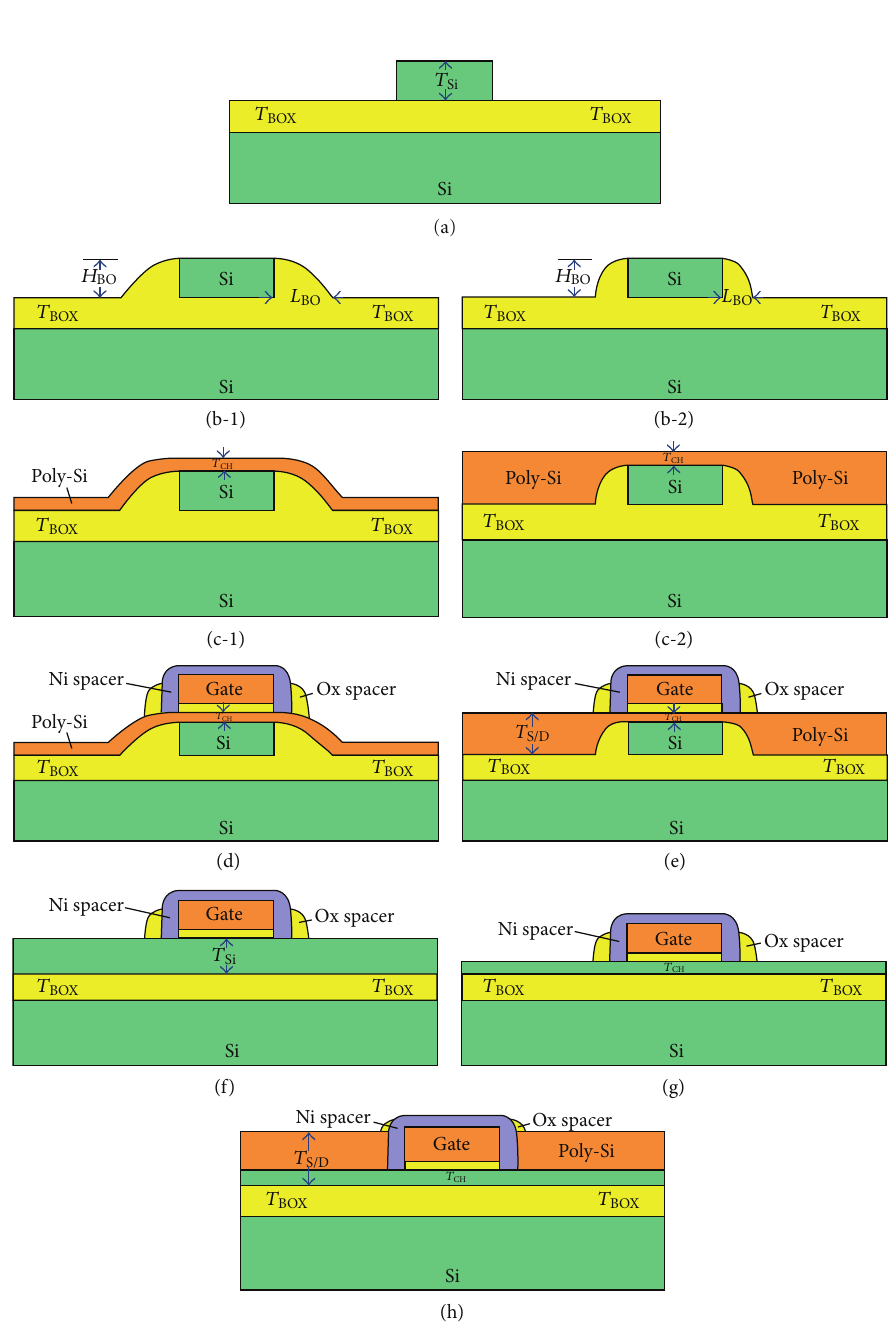
Figure 1: Schematic of the process flow of bFDSOI-FETs. (a) Si body patterning. (b-1) Block-oxide formation, where the height of the block- ) is equal to the Si body thickness ( 𝑇 ) and the length of the block-oxide ( 𝐿 ) is 60 nm for thin S/D bFDSOI-FET. (b-2) Block- oxide ( 𝐻 BO Si BO is equal to the 𝑇 and the 𝐿 is 15nm for recessed S/D bFDSOI-FET. (c-1) Poly-Si deposition. (c-2) Poly-Si oxide formation, where the 𝐻 BO Si BO deposition,planarization,anddepositionagain.(d)AthinS/DbFDSOI-FET.(e)ArecessedbFDSOI-FET.(f)AnFDSOI-FET.(g)AUTBSOI- and poly-Si channel thickness ( 𝑇 ) are FET. (h) An E-S/D UTBSOI-FET. For thin S/D and recessed S/D bFDSOI-FETs, typical values of 𝑇 Si CH is 30nm. For UTBSOI-FET, the typical value of 𝑇 (= 𝑇 ) is 5 nm. For 30 nm and 5nm, respectively. For FDSOI-FET, the typical value of 𝑇 Si Si CH (= 𝑇 ) and poly-Si raised S/D thickness are 5nm and 30 nm, respectively. For other parameters, E-S/D UTBSOI-FET, typical values of 𝑇 Si CH ) and front-gate oxide thickness ( 𝑇 ) are 50 nm and 1.4 nm, BOX thickness ( 𝑇 BOX GOX